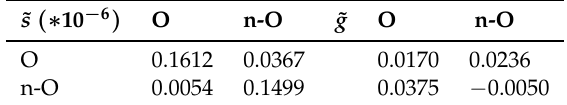
Table 6. Parameter calibration for spillover parameter: ˜ s and ˜ g , linearized model.